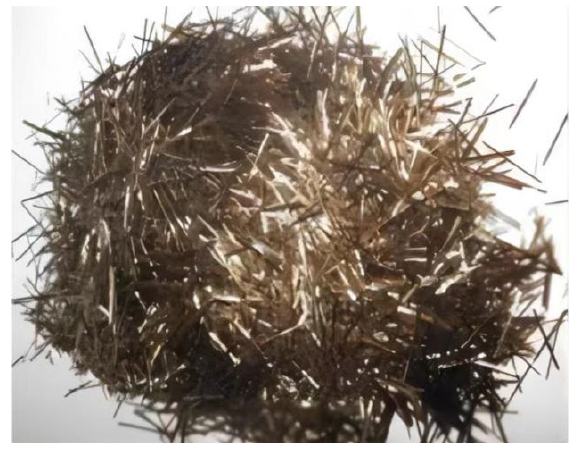
Figure 1. Basalt fiber samples.